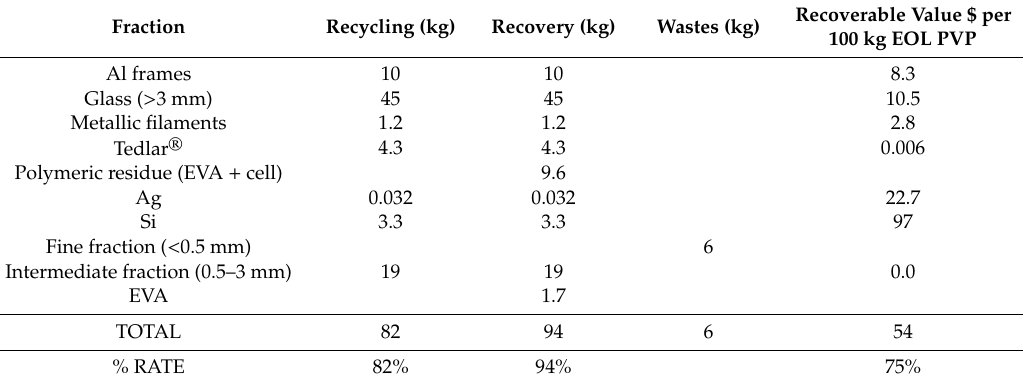
Table 5. Recycling rate, recovery rate amount of wastes produced, and recoverable value according to mass balances for the advanced PhotoLife process for 100 kg of EOL PVP as